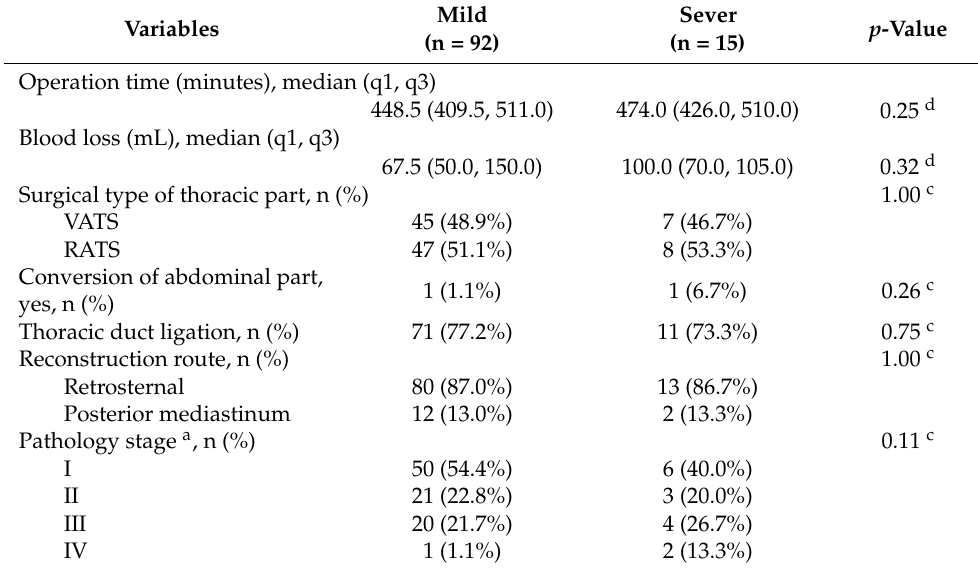
Table 2. Surgical variables of the two